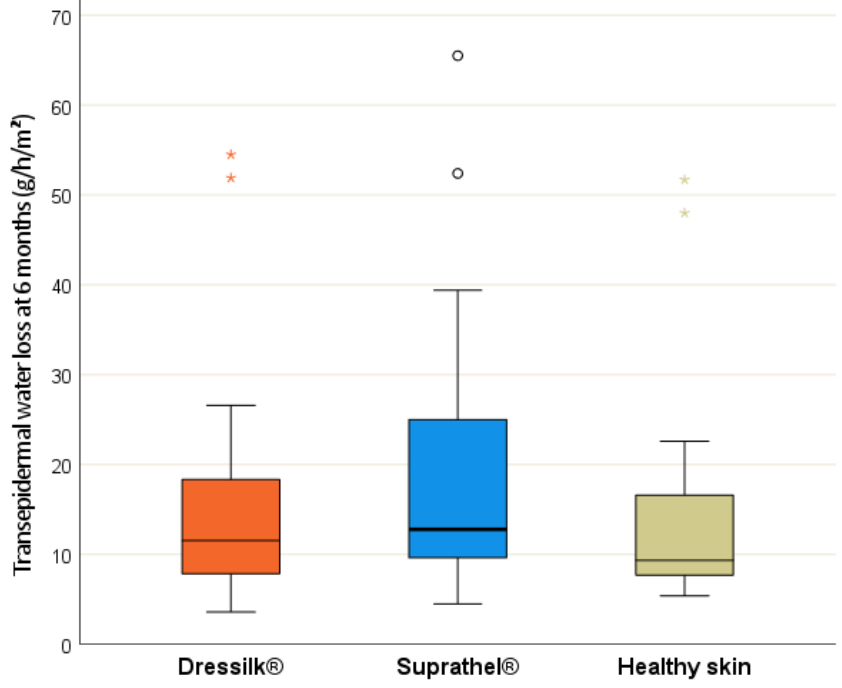
Figure 5. Transepidermal water loss (TEWL) in g/h/m 2 after 6 months of areas treated initially with Suprathel (blue), Dressilk (orange) and the uninjured control area (green), significant differences marked.